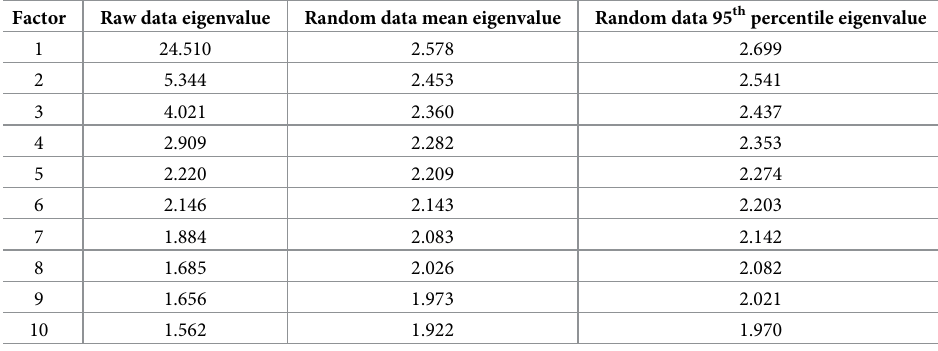
Note . Eigenvalues are only given for the first 10 factors and are not given for the remaining 74 potential factors. A